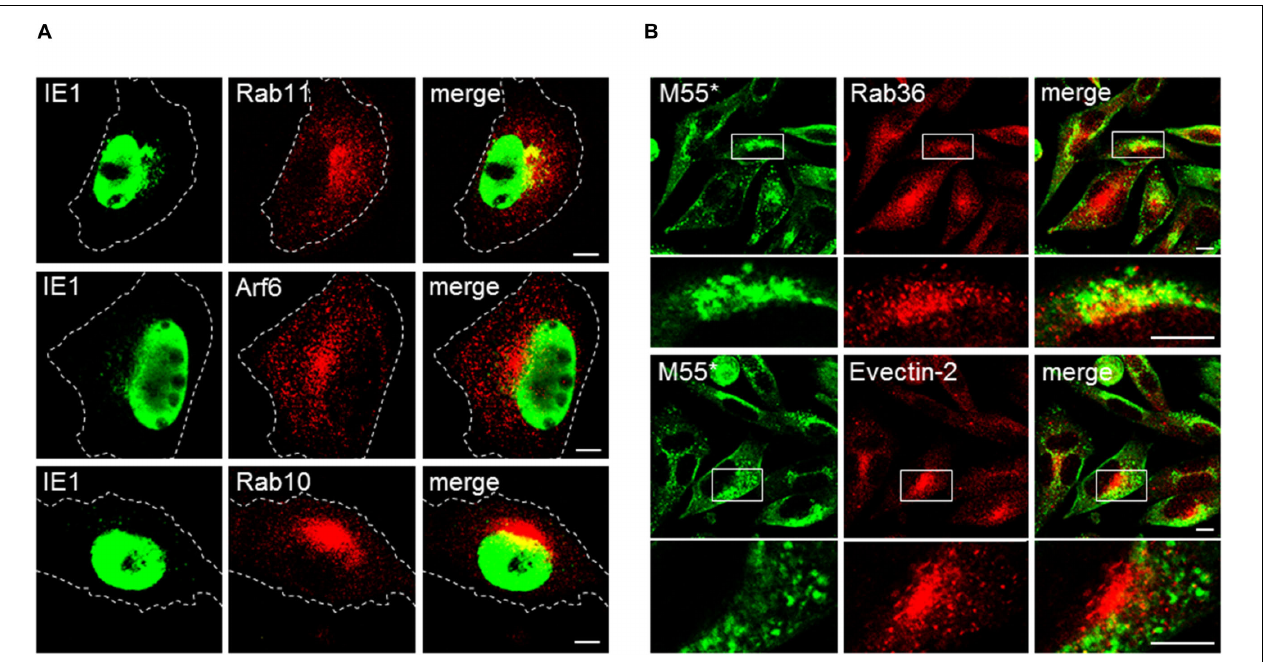
FIGURE 8 | Membranous organelle reorganization in cells infected with the recombinant MCMV with deleted genes that mediate cell rounding. Balb 3T3 cells were infected with (cid:49) 9-MCMV (with deleted M23-M26 genes) and analyzed at 16 (A) and 30 hpi (B) for subcellular localization of selected ERC markers and IE1 and M55 proteins. M55* staining indicates subcellular localization of the M55 gene product and FcR binding by m138/fcr1 gene product, which was not deleted in (cid:49) 9-MCMV. Note that fcr1 binds murine IgG 2a but not rabbit IgG. Cell borders are indicated by fine dashed lines. Lower panel images in (B) represent the boxed area acquired at higher magnification. Bars, 10 µ m. 2-column fitting